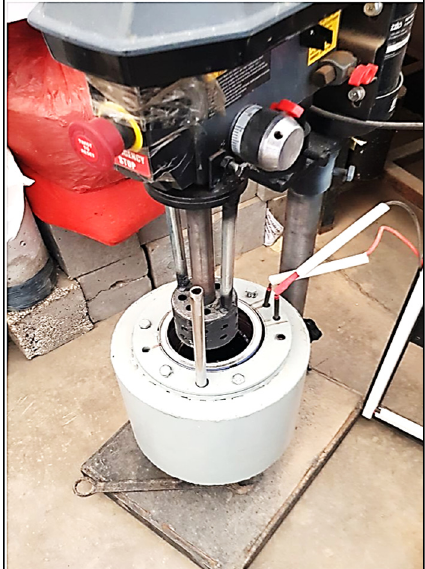
Figure 7. Asphalt binder blender.